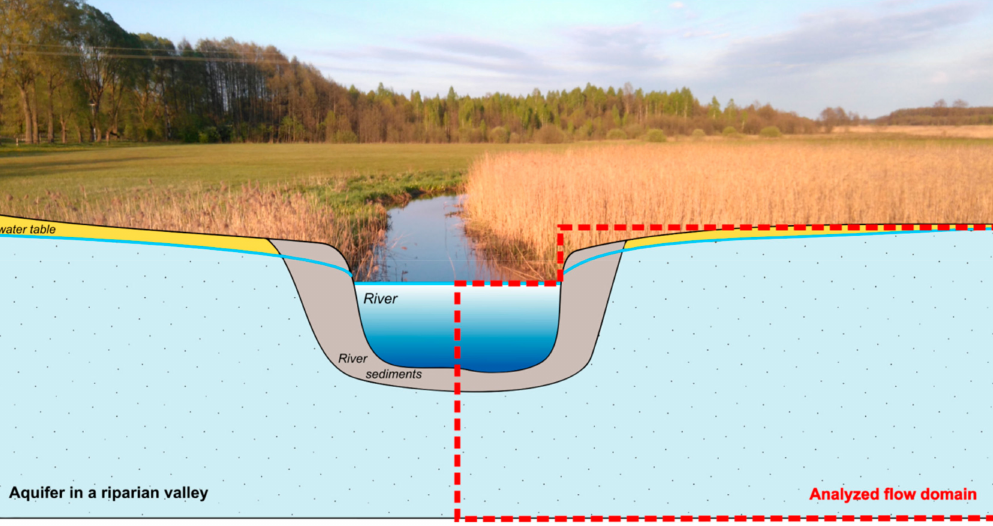
Figure 2. River–aquifer system of the Upper Biebrza River in Poland and outline of the exemplary system geometry used in the AHF and SEEP2D